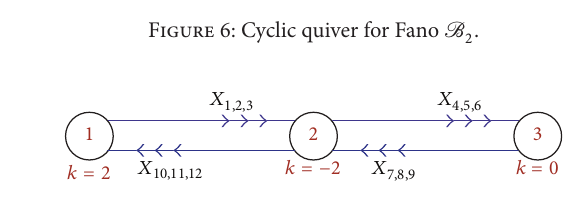
Figure 7: Linear quiver for Fano B 2